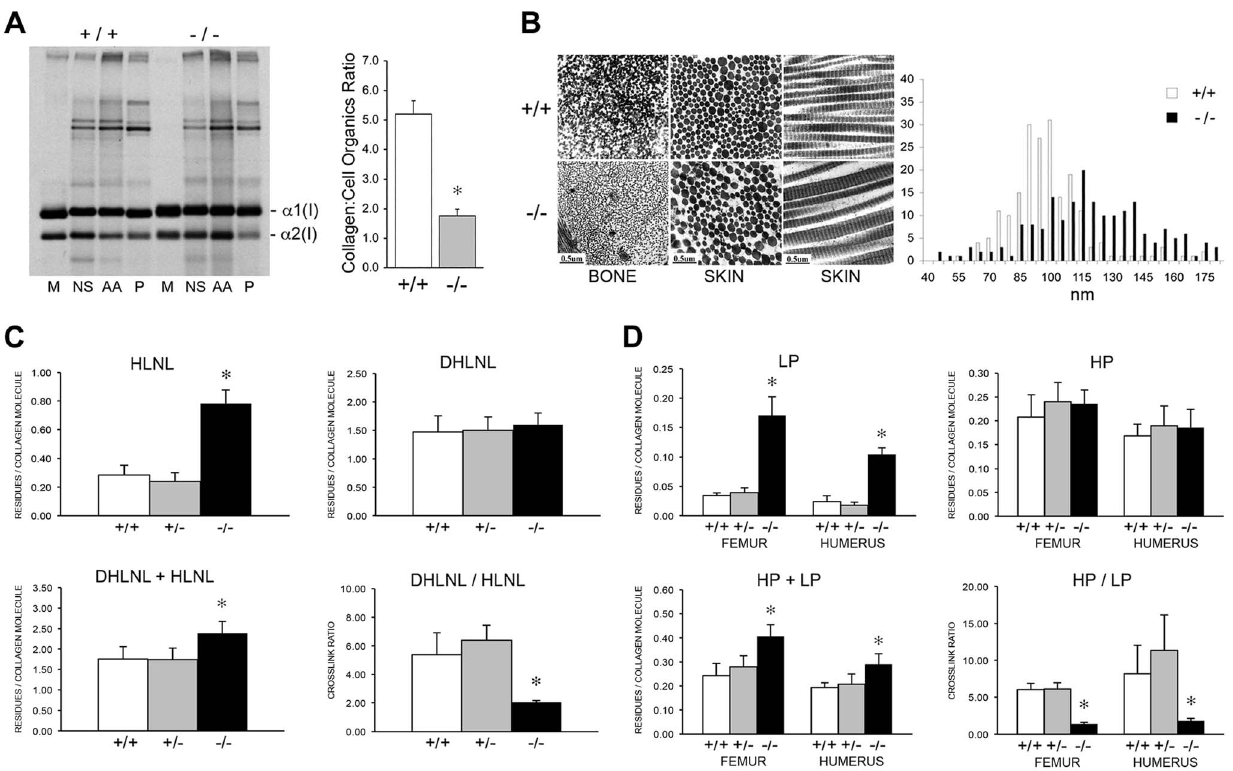
Figure 10. Dysregulation of collagen deposition and fibril assembly. (A) Left , Deposition of type I collagen by osteoblasts into extracellular matrix in culture. Post-confluent cultures were pulsed for 24 hr, followed by serial extraction of incorporated collagens from the media (M), neutral salt (NS), acid soluble (AA, immaturely crosslinked) and pepsin soluble (P, maturely crosslinked) fractions of the matrix. Right , Matrix collagen to cell organics ratio from Raman micro-spectroscopy shows decreased collagen content in matrix deposited by homozygous Ppib -null ( 2 / 2 ) versus wild- type ( + / + ) osteoblasts in culture (p=0.002). (B) Transmission electron micrographs of femoral and dermal collagen fibrils from 8 week-old wild-type ( + / + ) and CyPB-deficient mice ( 2 / 2 ). Diameters of 200 dermal fibrils were measured for each sample and plotted, right. (C) Quantitation of divalent crosslinks in murine humeri reveals increased HLNL (hydroxylysinonorleucine) crosslinks, which require helical lysine residues, but no change in DHLNL (dihydroxylysinonorleucine) crosslinks, which involve helical hydroxylysine residues. (D) Quantitation of trivalent crosslinks in murine humeri and femora. Total pyridinoline crosslinks are increased due to an increase in lysyl pyridinoline (LP), but not hydroxylysyl pyridinoline (HP) crosslinks in